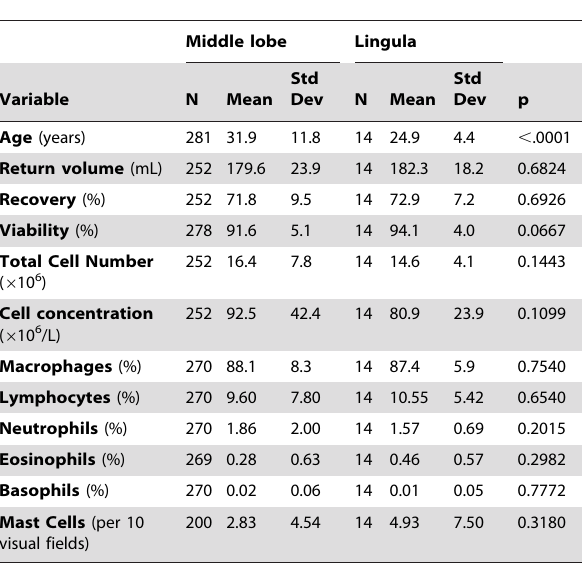
Table 6. Comparison of bronchoalveolar lavage fluid findings between the middle lobe and the lingula in healthy never- smoking